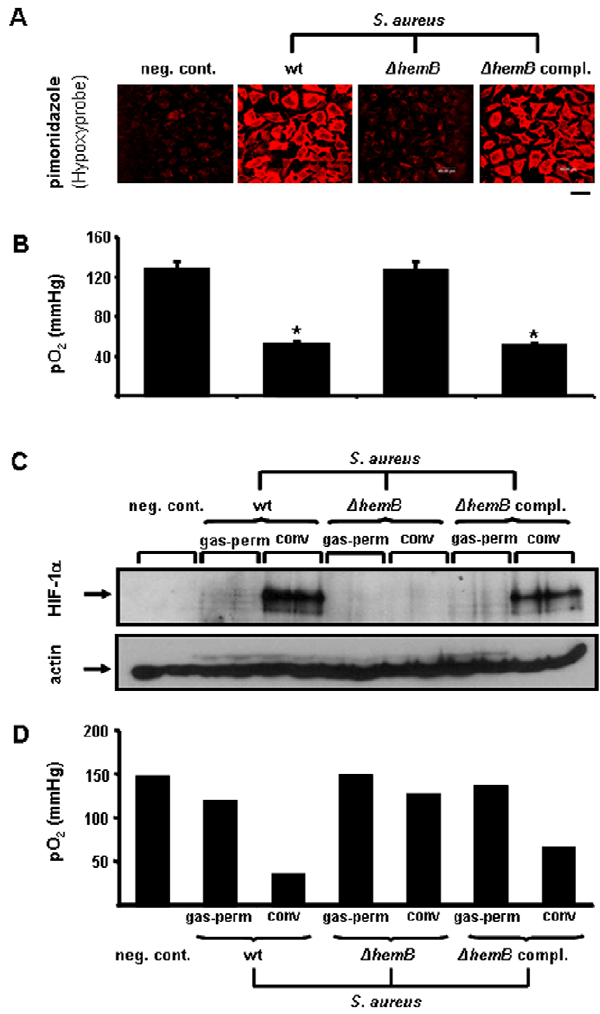
Figure 7. Cellular oxygen consumption and oxygen-dependent HIF-1 activation in HeLa-229 cells infected with different S. aureus strains. (A) Control and infected HeLa-229 cells were incubated with the hypoxic marker pimonidazole hydrochloride which was visualized by using specific Cy3 labelled antibodies (for details see Materials and Methods). Scale bare: 40 m m. (B) pO 2 levels were quantified in the medium of control and infected cells (triplicate means given). (C) Hela-229 cells were incubated in gas permeable (gas-perm) and conventional (conv) culture dishes and HIF 1 a protein was analyzed in Western blots (loading control: actin). (D) pO 2 levels in the medium of control or S. aureus infected HeLa-229 cells (means of doubles). Negative control: uninfected cells; S. aureus wt (8325-4); S. aureus D hemB ( S. aureus ermB V hemB 8325-4, SCV); S. aureus D hemB , hemB - complemented ( S. aureus pCX19 V hemB 8325-4, complemented SCV mutant). Multiplicity of infection (MOI): 20. * significant difference to control cells (P , 0.05).